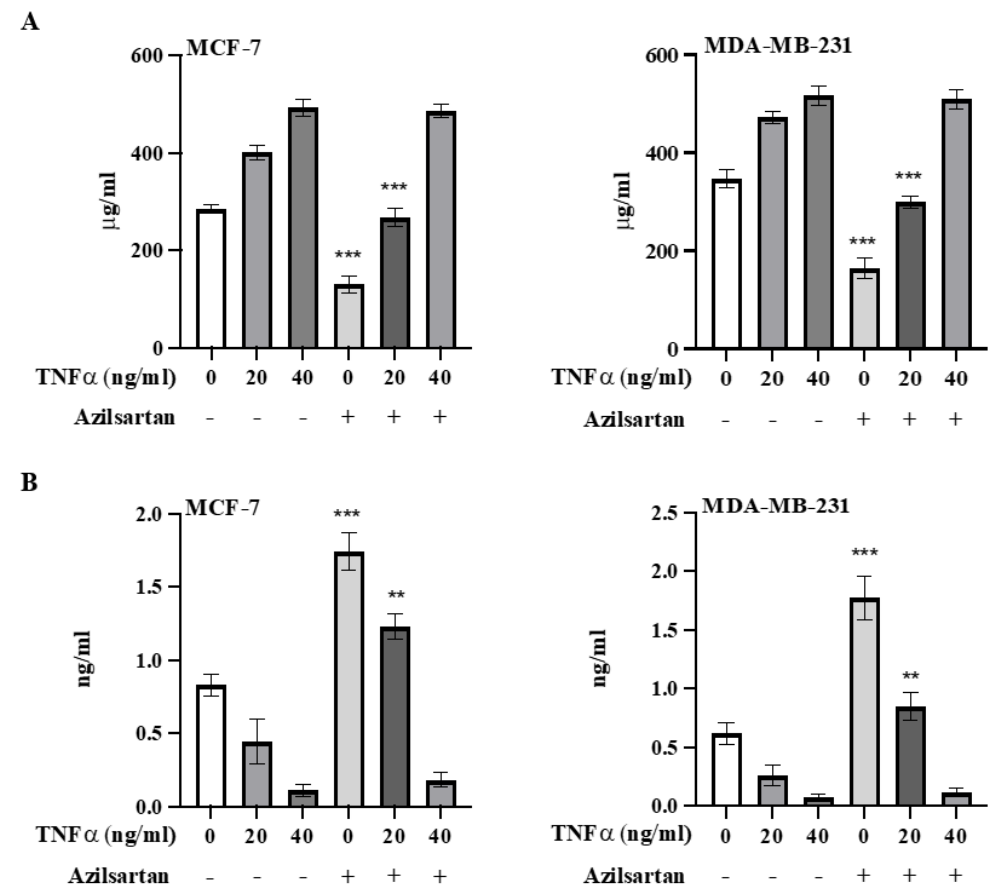
Figure 9. Effect of azilsartan on TNF α -induced NF-kB activation. The levels of NF-kB p65 ( A ) and cleaved caspase 3 ( B ) proteins in non-stimulated and TNF α (20 and 40 ng/mL)-stimulated MCF-7 and MDA-MB-231 cancer cell lines were measured. Bars represent mean ± SD, n = 3. Significant difference was analyzed by student t test, where ** p < 0.01, *** p < 0.001, compared to the corresponding azilsartan-untreated cells.